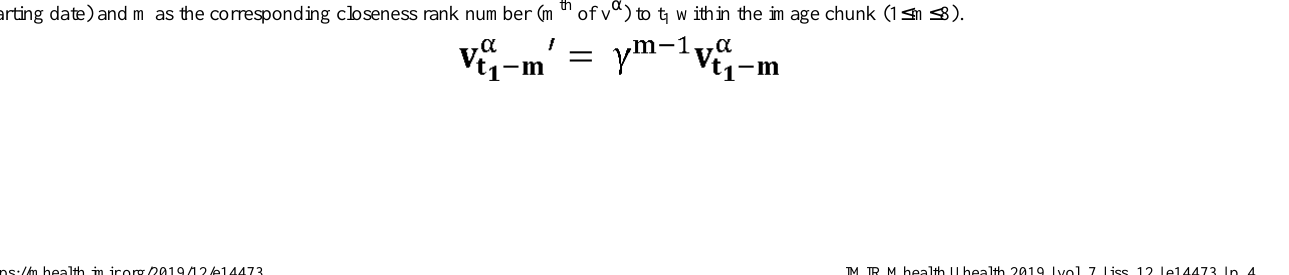
JMIR Mhealth Uhealth 2019 | vol. 7 | iss. 12 | e14473 | p. 4https://mhealth.jmir.org/2019/12/e14473 (page number not for citation